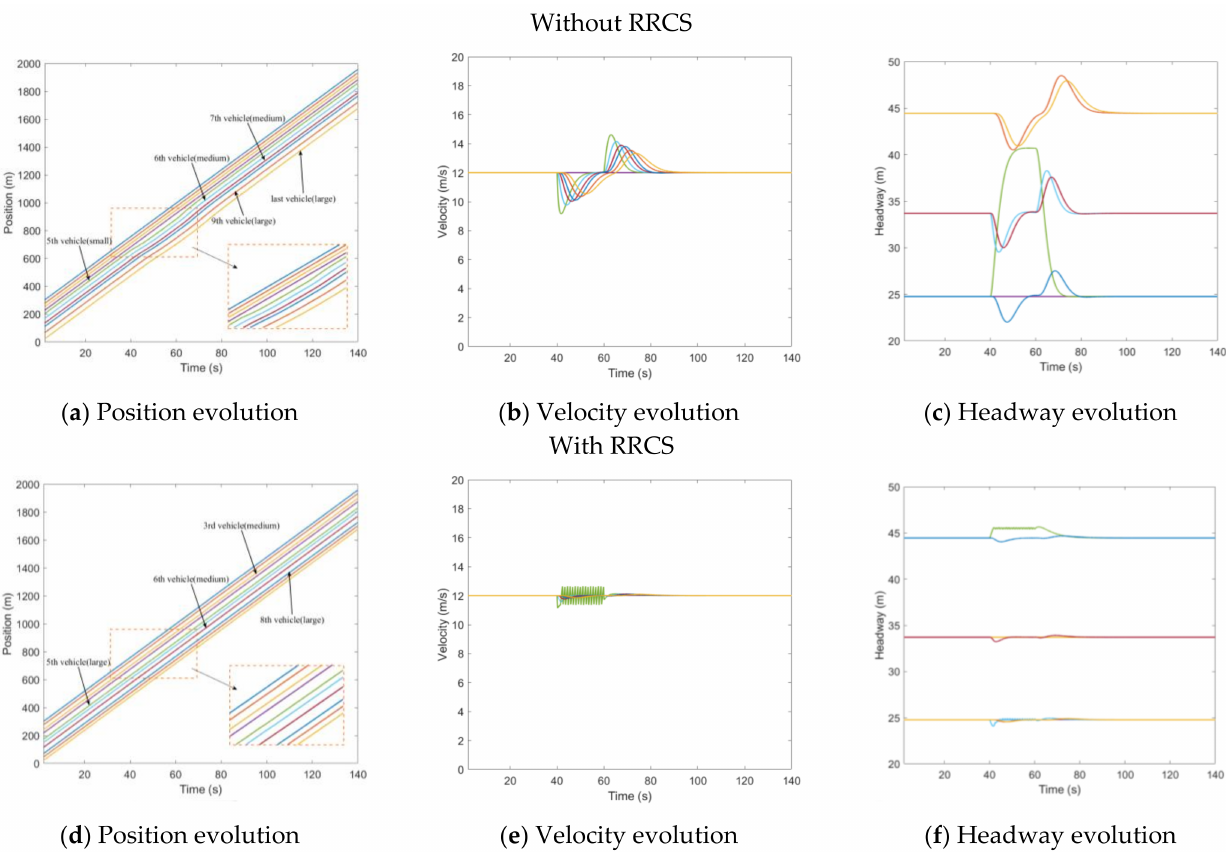
Figure 4. Mixed traffic flow evolution diagrams under the underestimated velocity with/without